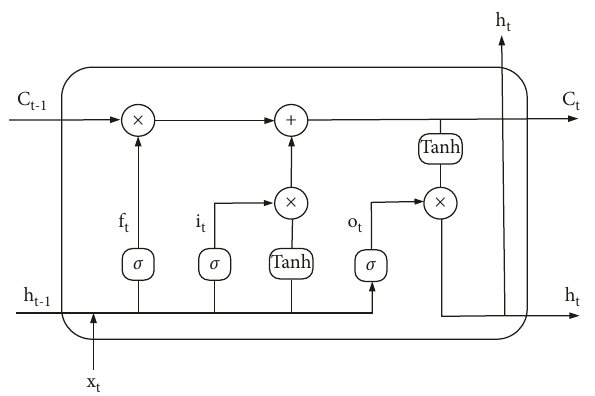
Figure 3: The structure of long short-term memory network.